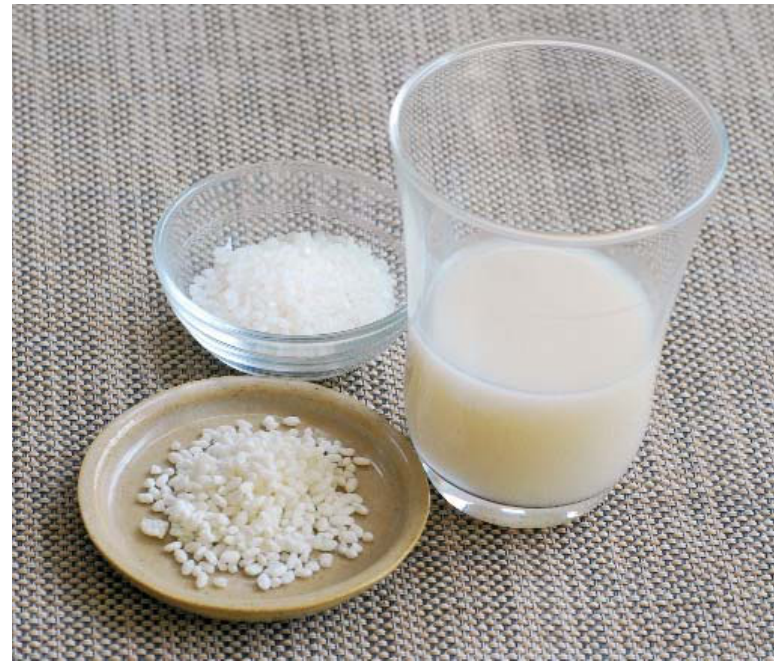
Figure 2. Rice, rice- koji and koji amazake .